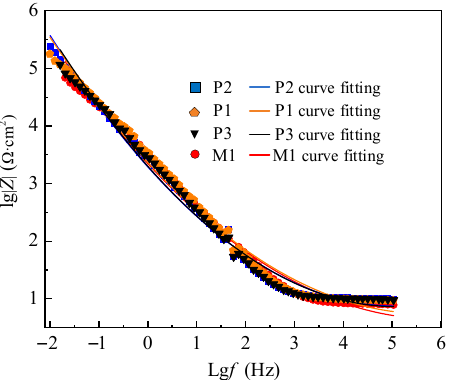
Figure 11. Impedance test and Bode spectrum of milling and electrochemical polishing samples.